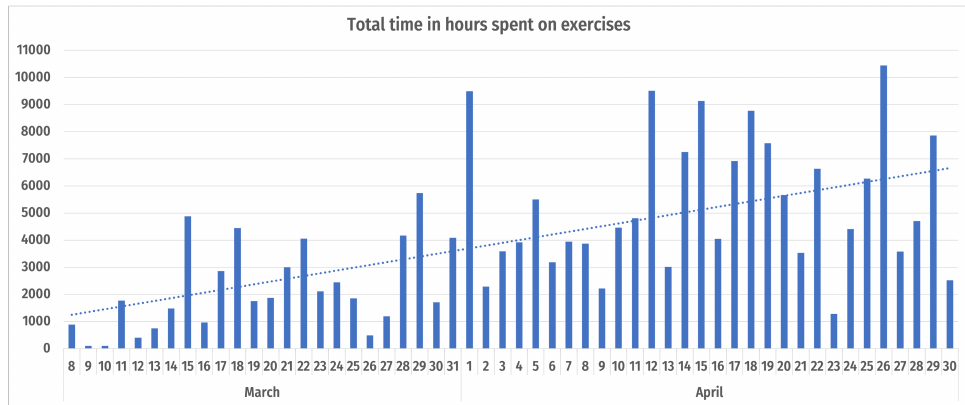
Figure 9. Time in hours spent by students to do the hands-on